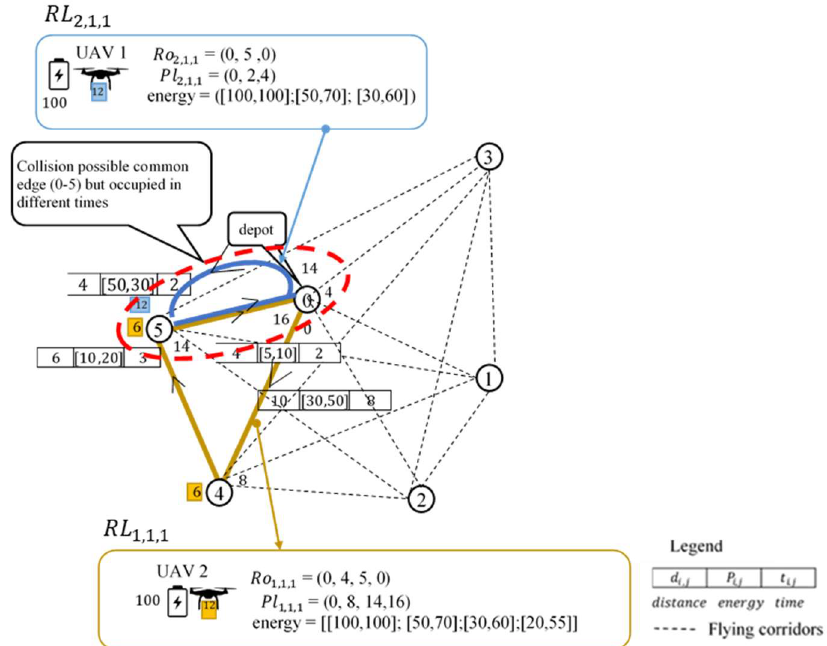
Figure 9. Scenarios assigned to UAVs, which have routes with common edge occupied at different times.